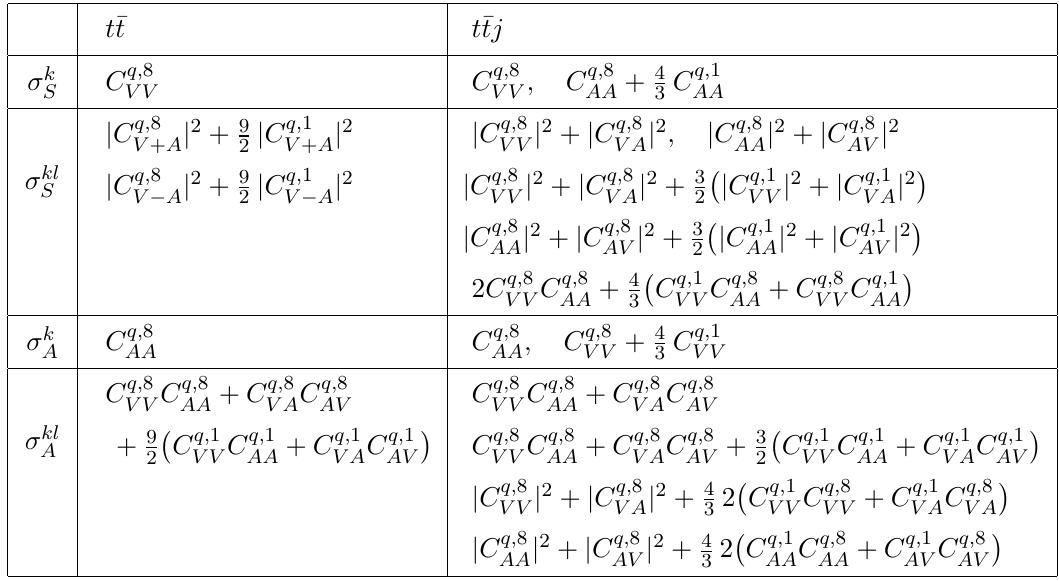
and (cid:27) kl , respectively. S;A S;A